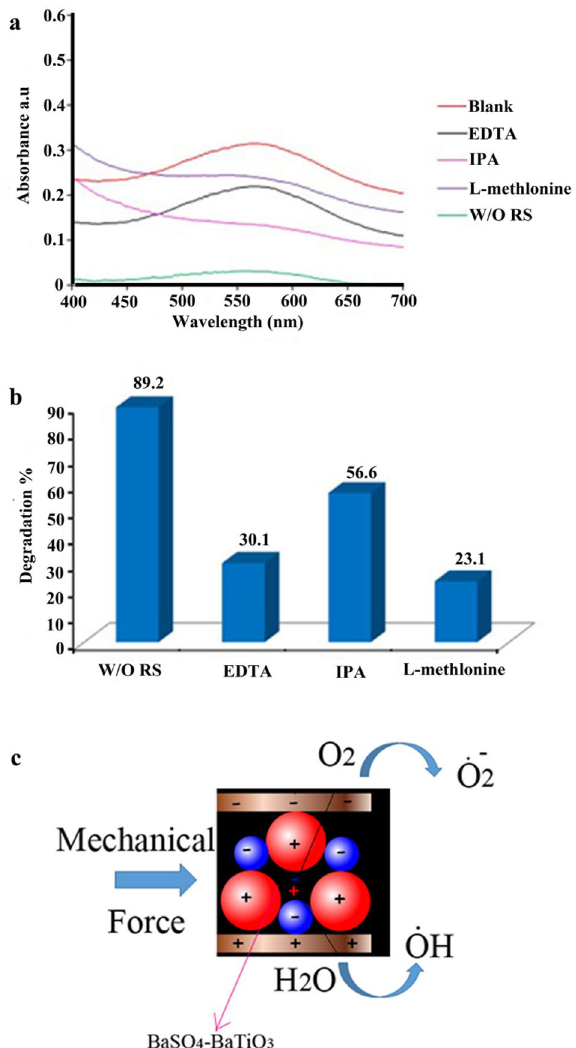
Figure 13. Possible mechanism for decontamination of AB113 by using a piezocatalyst. EDTA, IPA, and L-methionine as the hole (h + ), hydroxyl radical (·OH), and peroxide radical (O2· −2 ) scavengers, respectively. ( a ) Related spectrum, ( b ) related degradation efficiency, and ( c ) schematic for piezo degradation.